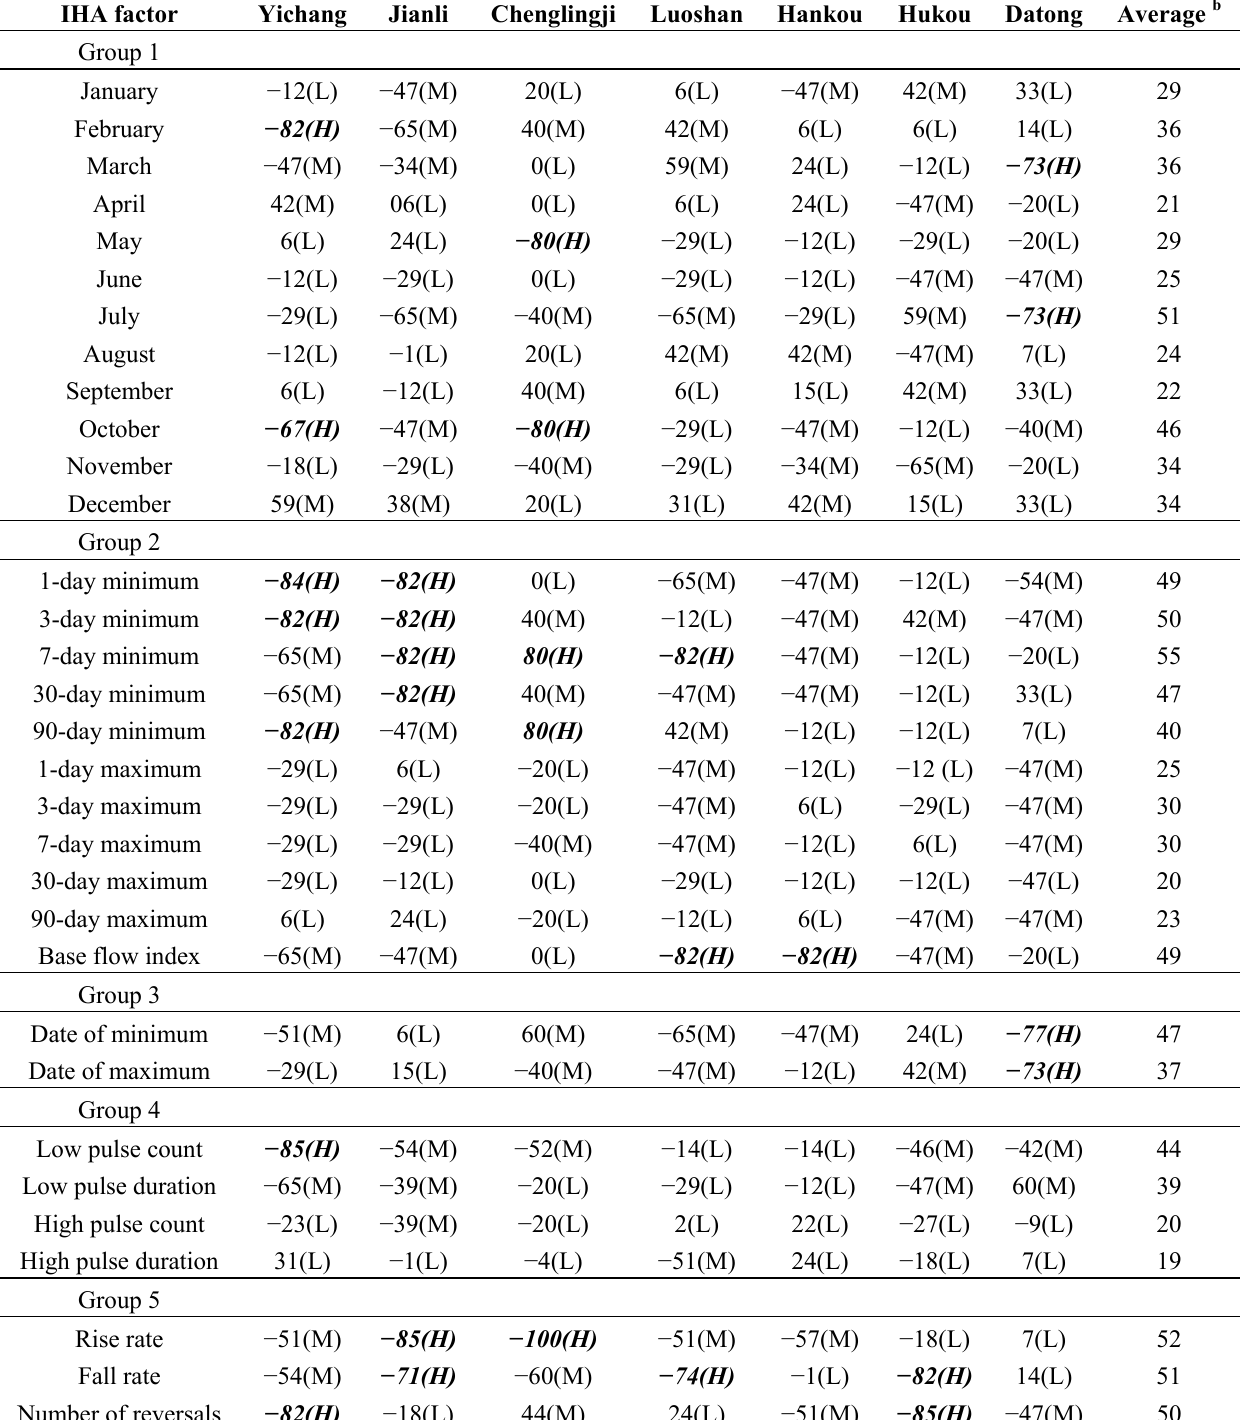
Table 2. Measures of hydrologic alteration (HA) a (%) at seven hydrological stations. IHA